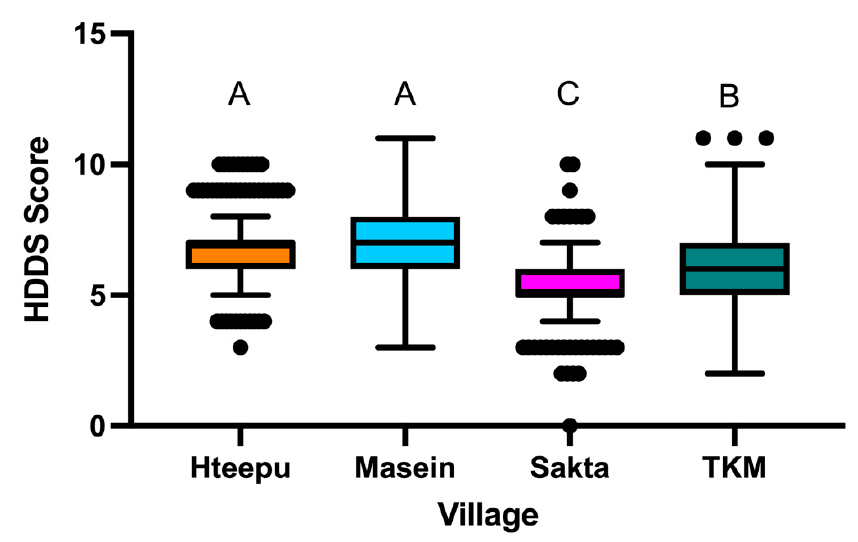
Figure 3. HDDS Scores recorded from four Myanmar CSVs. The central line of each column represents the mean HDDS Score for each CSV ± the standard error, with the outermost lines representing standard deviation. One-way ANOVA was used to determine statistical differences; villages with different letters are significantly different at a 95% confidence interval.